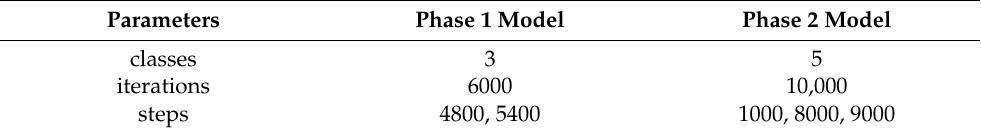
Table 2. The hyperparameter setting of the